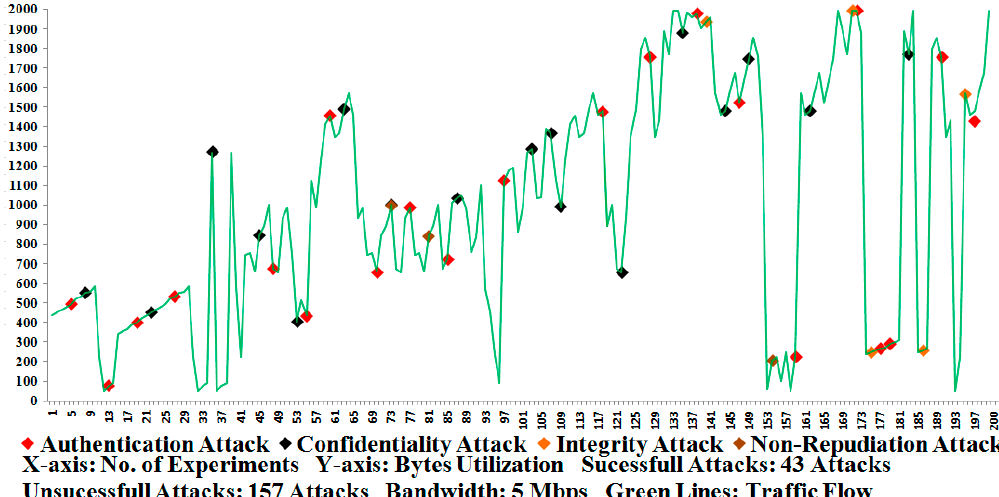
Figure 10. Security test using end-to-end DNP3 security.